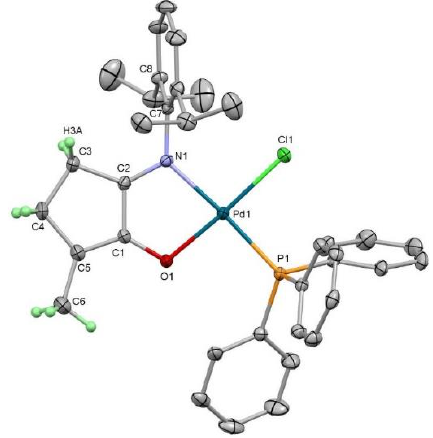
Figure 2. Molecular structure for compound 3 with 50% ellipsoids (all H atoms, except for selected H atoms on the imino-enolate ligand, are omitted for clarity). Selected bond lengths (Å ) and bond angles ( ◦ ): Pd1-Cl1 2.2905(6), Pd1-P1 2.2530(6), Pd1-O1 2.018(2), Pd1-N1 2.099(2), O1-C1 1.328(3), C1-C5